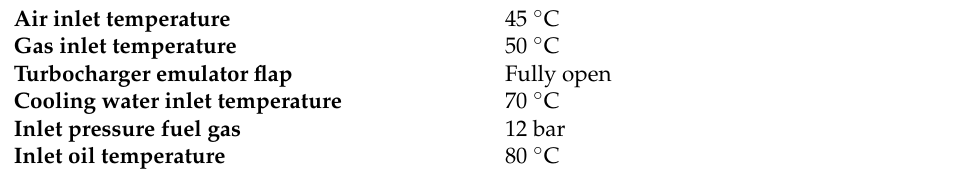
Table 5. Boundary